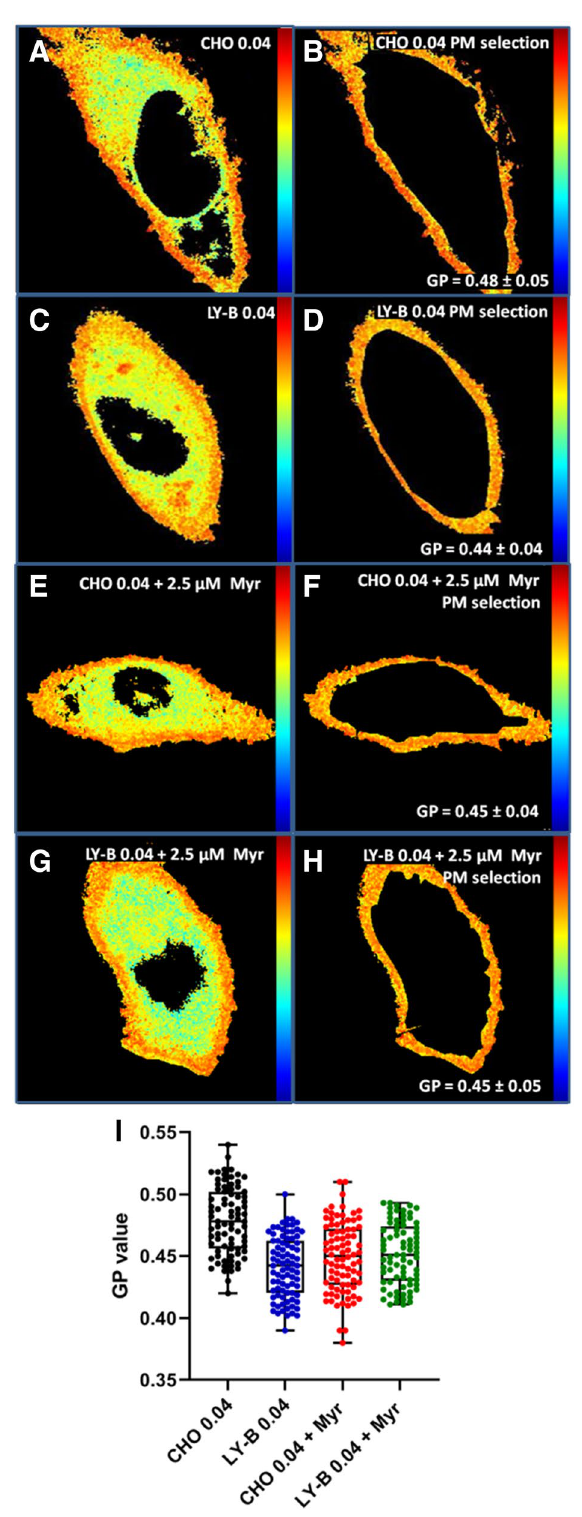
Figure 5. Laurdan staining and GP processing. A representative CHO cell grown in deficient medium ( A ), and the PM selection of the cell in panel A ( B ). A representative LY-B cell grown in deficient medium ( C ), and the PM selection of the cell in panel C ( D ). A representative 2.5 µM myriocin-treated CHO cell grown in deficient medium ( E ), and the PM selection of the cell in panel E ( F ). A representative 2.5 µM myriocin-treated LY-B cell grown in deficient medium ( G ), and the PM selection of the cell in panel E ( H ). Box plot graph of GP values of non-treated and myriocin-treated CHO (black and blue dots) and LY-B (red and green dots) PM selection values, including average values ± S.D. Three independent experiments were performed; n = 75 (25 PM selections × 3 replicas). Treated vs non-treated CHO cell P = 0.027 ( I ). Statistical significance was calculated with the Student´s